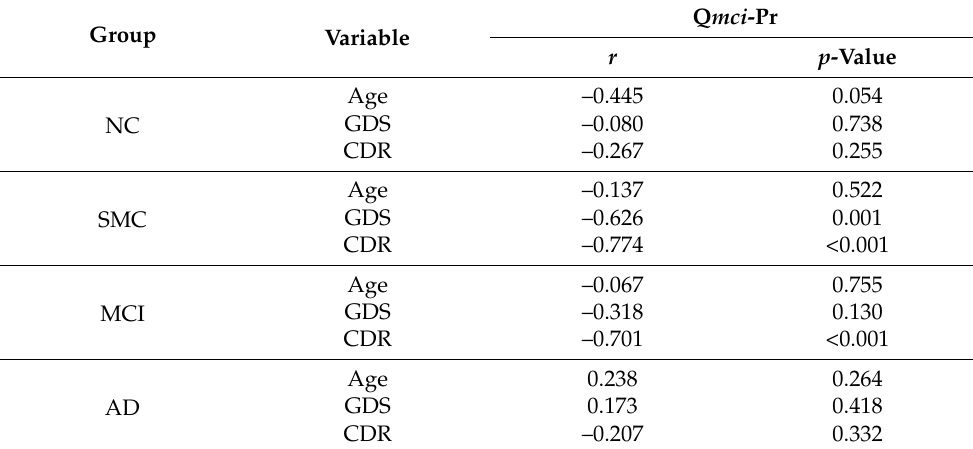
Table 2. Correlations between Q mci -Pr screen scores and age, GDS and CDR scale scores in the four diagnostic groups NC, SMC, MCI, and AD.